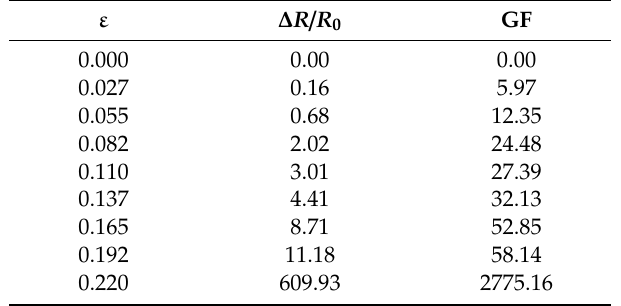
Figure 7. Plots of relative resistance change ( ∆ R / R 0 ) versus stretching strain ( ε ) for the LRS and the HRS of the NT resistive memory. Table 1. Listed LRS data of ∆ R / R 0 versus ε for the gauge factior (GF) calculation.